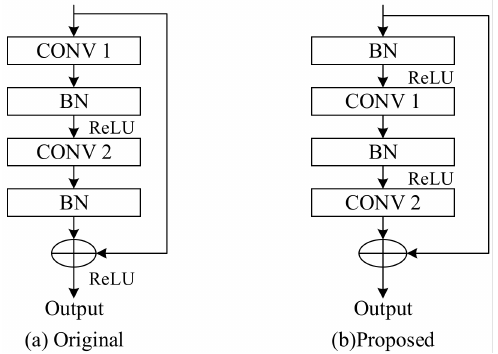
Figure 3. Residual building block. ( a ) original. ( b )